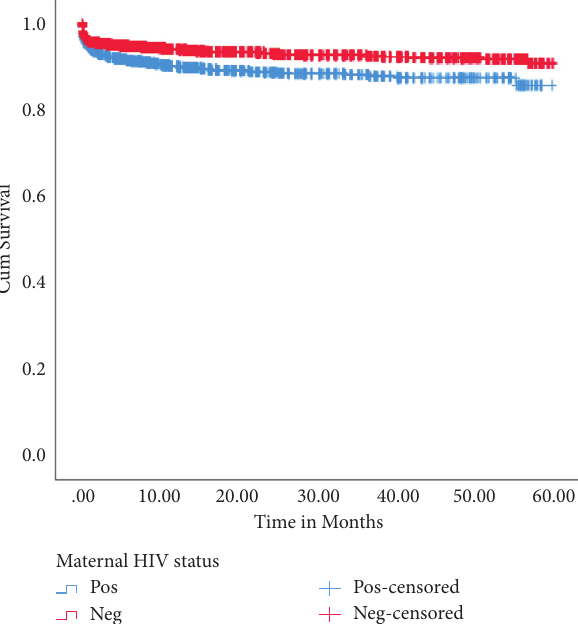
Figure 1: Kaplan–Meier survival curves of UFC born to women living with and not living with HIV between Jan 2014 and Dec 2018 in Botswana ( N � n � 12,798) (Log-rank (Mantel–Cox) chi- square � 37.59, p � 0 . 001).